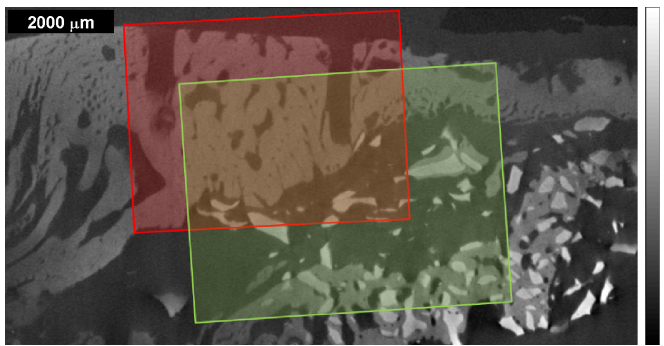
Figure 1. µ-CT image of the bone sample from an adult mini-pig, whose sinuses were grafted in a previous medical study [14] with autogenous bone derived cells and bovine bone mineral. Dark gray corresponds to materials with lower X-ray absorption (e.g., air), while bright gray to materials with higher X-ray absorption (e.g., dense structures). The overlapping regions of interest (ROI) delimit the areas of the Raman maps taken: red area called ROI 1 for the 1st Raman measurement with the wet sample; green area called ROI 2 for the 2nd Raman measurement with the dry sample. The saw kerfs have been used as orientation attributes within the µ-CT image and the Raman maps.